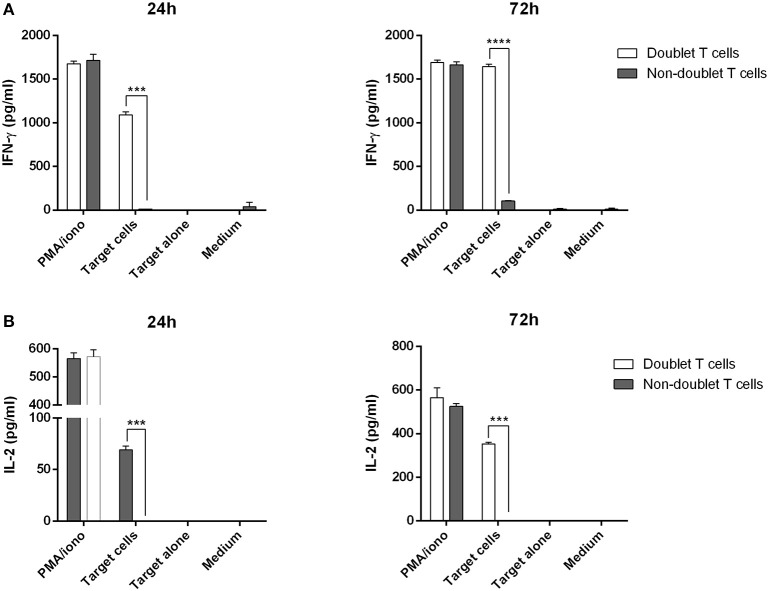
Cytokine production of doublet-forming T cells. Doublet T cells and non-doublet T cells were co-cultured with target cells for 24 and 72 h. (A) IFN-γ and (B) IL-2 levels in supernatants were measured by ELISA (stimulation performed in duplicates). Data show mean values ± SD of one representative experiment. P-values between the indicated groups were calculated using paired Student t- tests. ***p < 0.001 and ****p < 0.0001.